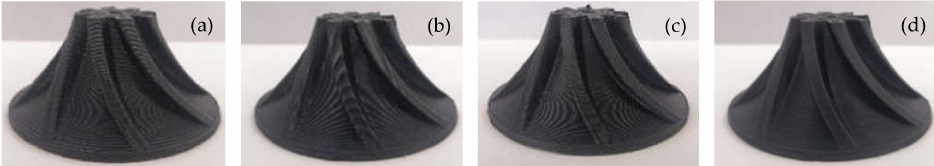
Figure 11. Finished parts of turbine blade model. ( a ) Finished part with slicing thickness of 0.4 mm. ( b ) Finished part with slicing thickness of 0.3 mm. ( c ) Finished part with slicing thickness of 0.2 mm. ( d ) Finished part manufactured using adaptive layering based on optimal volume